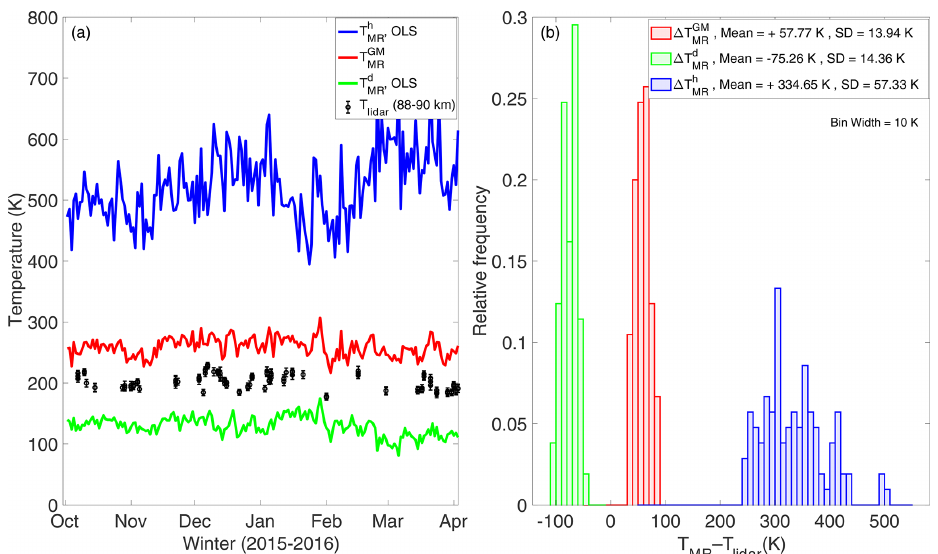
Figure 3. (a) Temperature estimated in OLS method using log 10 ( 1 /τ) (green) and height (blue) as an independent variable. Also shown are (red) the temperatures obtained using the geometric mean (GM) fitting and the lidar temperatures (in black). (b) The offset between the lidar ( T lidar ) temperatures and the estimated MR temperatures ( T MR ) using OLS fitting and GM fitting (without contour